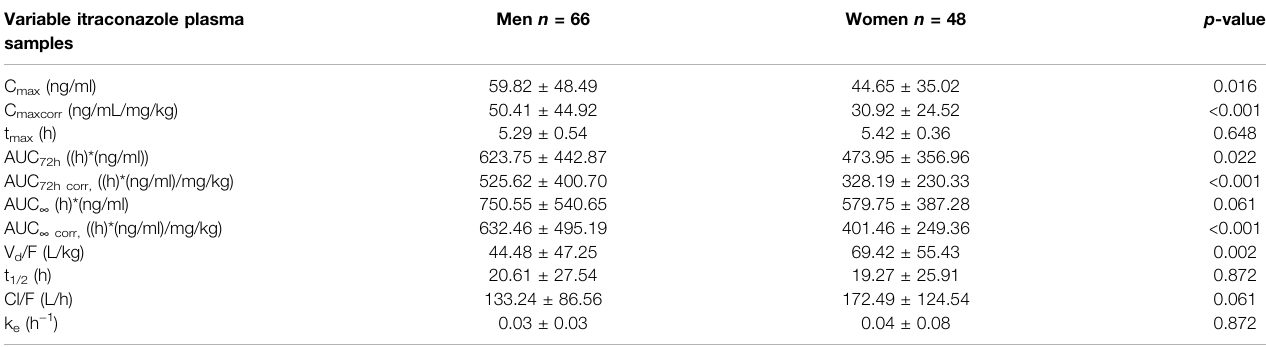
TABLE 3 | Pharmacokinetic parameters of itraconazole calculated from its 114 sets of plasma concentrations in both genders of human subjects after a single oral dose of 100 mg of drug obtained by non-compartmental analysis. Variable itraconazole plasma samples